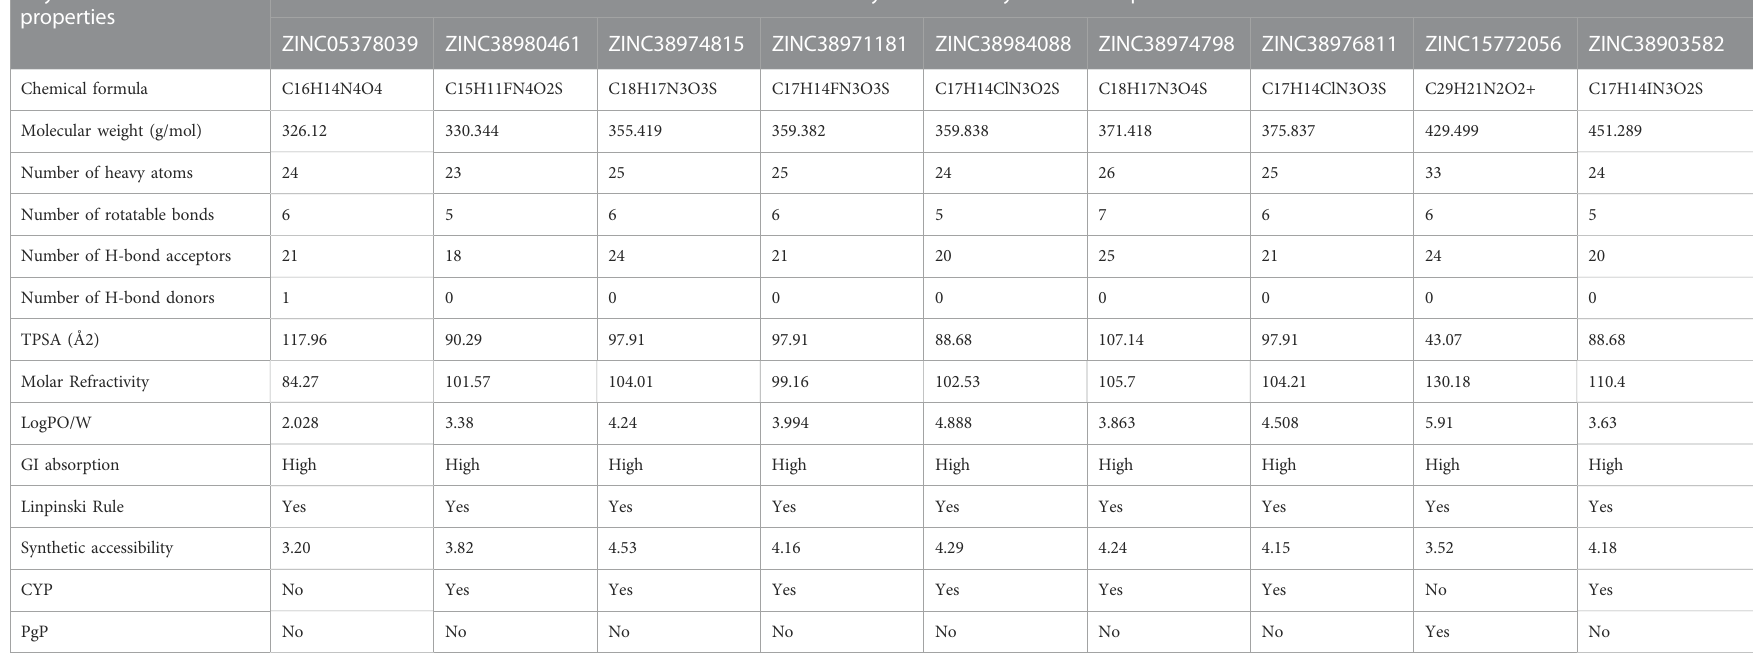
TABLE 2 ADME properties of Acetyl CoA Carboxylase